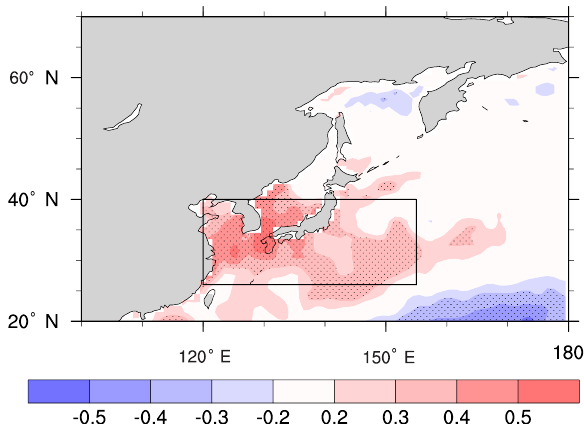
Figure 5. The correlation coefficients between the SSTA in the northwestern Pacific and the number of extreme anomalous southerly days in winter in North China from 1980 to 2016. The linear trend is removed before calculating the correlation. The black dots indicate a significant correlation at the 90% confidence level using the t